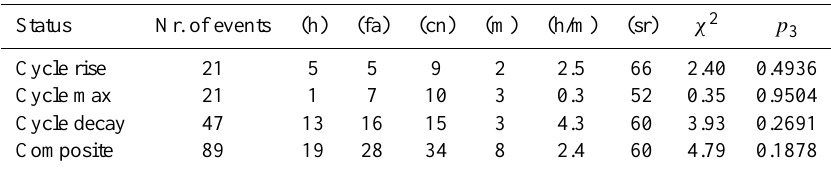
Table 9. Performance of the HAFv.2 model with respect to shocks with speeds < 1200kms − 1 originating at helio-longitudes > 80 ◦ during each of the key phases of solar cycle 23 and during the total cycle. Nr. of